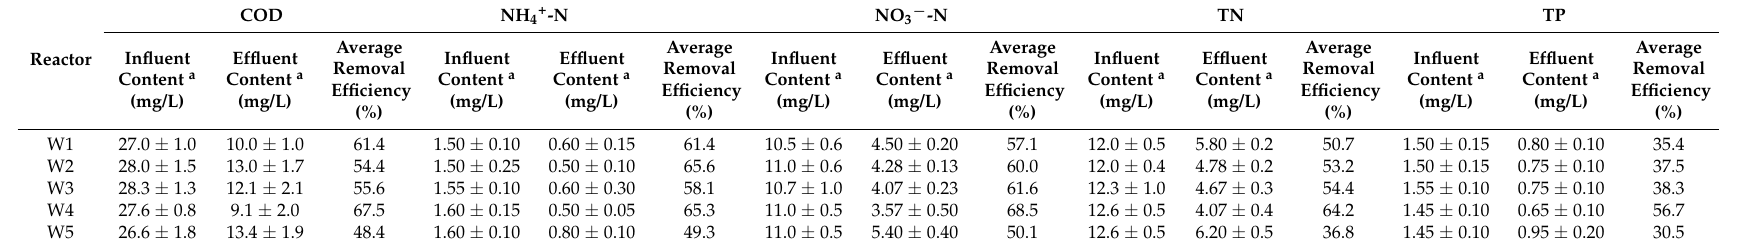
Table 1. The removal efficiency of COD, NH 4+ -N, NO 3 − -N, TN, and TP in five constructed wetlands before adding external